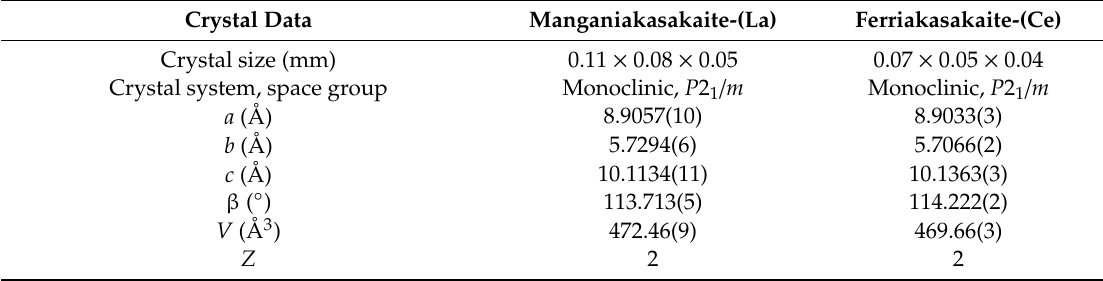
Table 4. Crystal data and experimental details for manganiakasakaite-(La) and ferriakasakaite-(Ce). Crystal